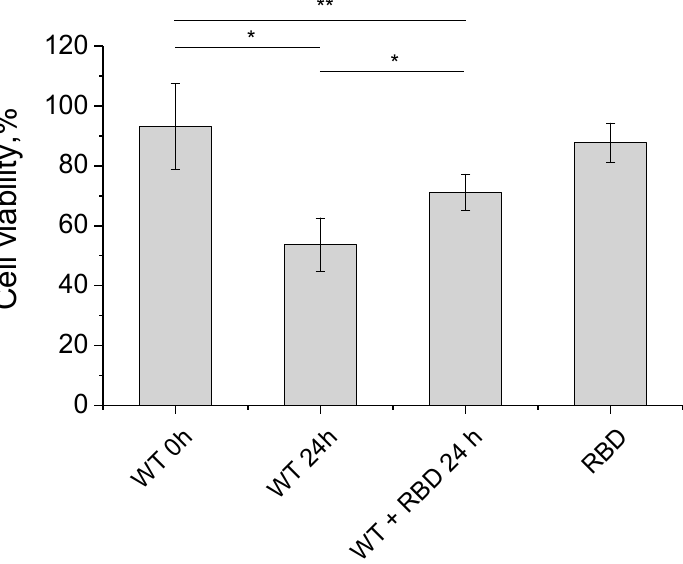
Figure 10. The effect of the alpha-synuclein fibrils, obtained in the presence of SARS-CoV-2 RBD, on neuroblastoma SH-SY5Y viability by MTT-test. The 28 µ M alpha-synuclein fibrils (with or without 5.6 µ M RBD) were produced for 24 h (as described in the Materials and Methods section). After dilution, 0.8 µ M synuclein, 0.26 µ M RBD, and 0.8 µ M synuclein with 0.26 µ M RBD (molar ratio 3:1) were added to SH-SY5Y neuroblastoma cells, and cell viability was determined after 24 h using the MTT test. p -value represents results of one-way ANOVA; * p < 0.05; ** p <